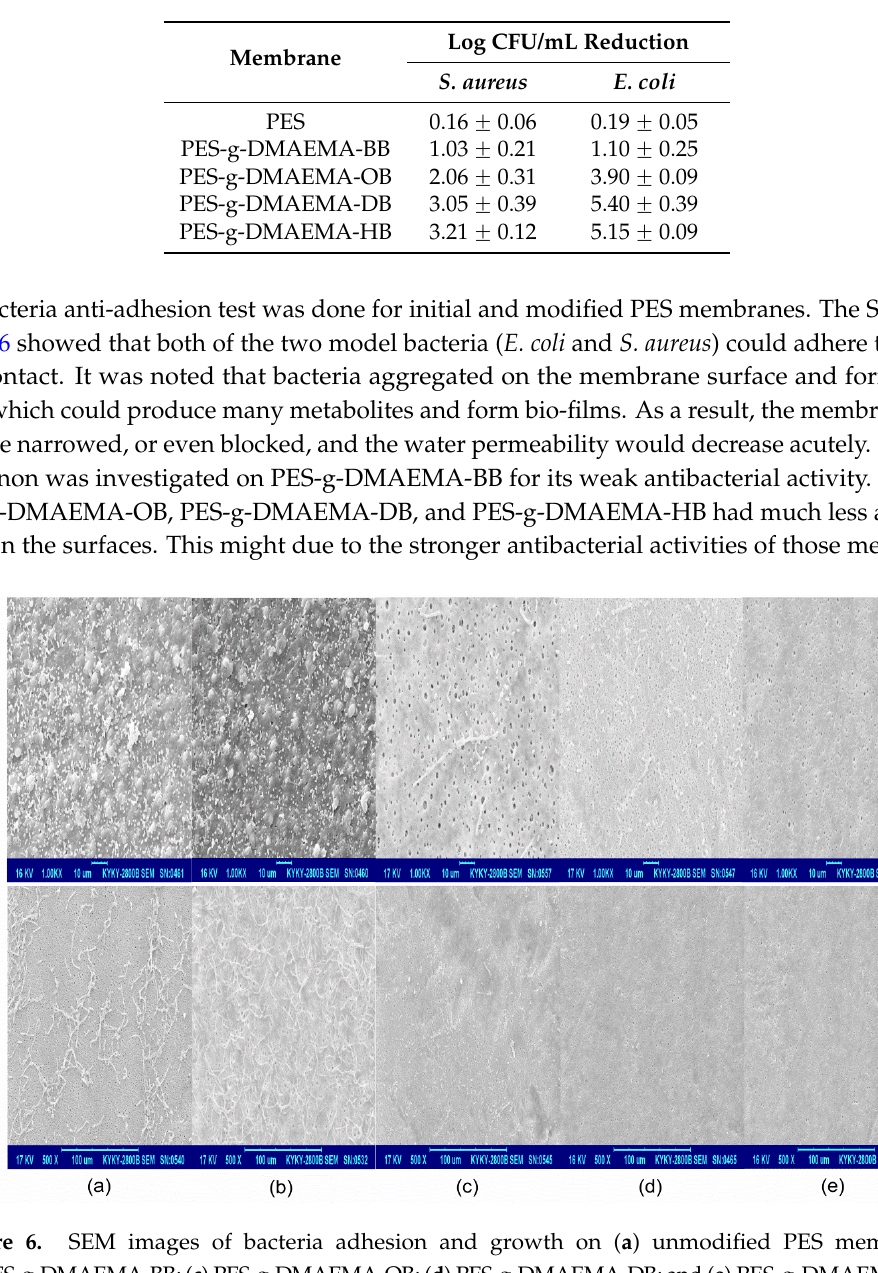
Table 2. Reduction in viable counts of S. aureus and E. coli (×10 7 CFU/mL) following contact with the membranes surfaces for 24 h at 37 °C.